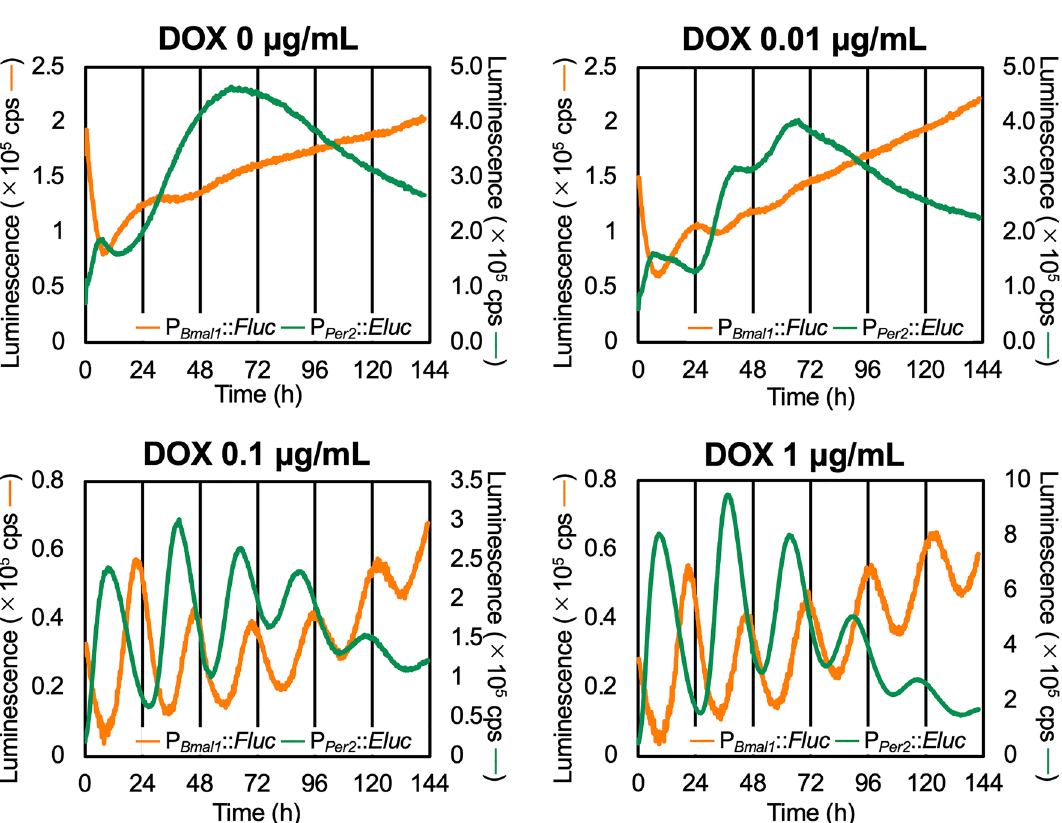
Figure 2. Constitutively expressed MYC-BMAL1 restores circadian rhythmicity in both P Bmal1 and P Per2 activity. U2OS-P